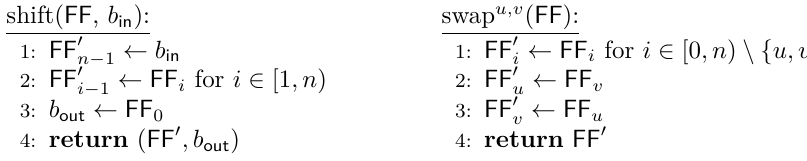
Table 4: Synthesis figures for the implemented bit-serial AEAD schemes using the STM 90 nm process. Energy and throughput figures are based on the processing of 1024 bits of plaintext and 128 bits of associated data. Area Power Latency Energy